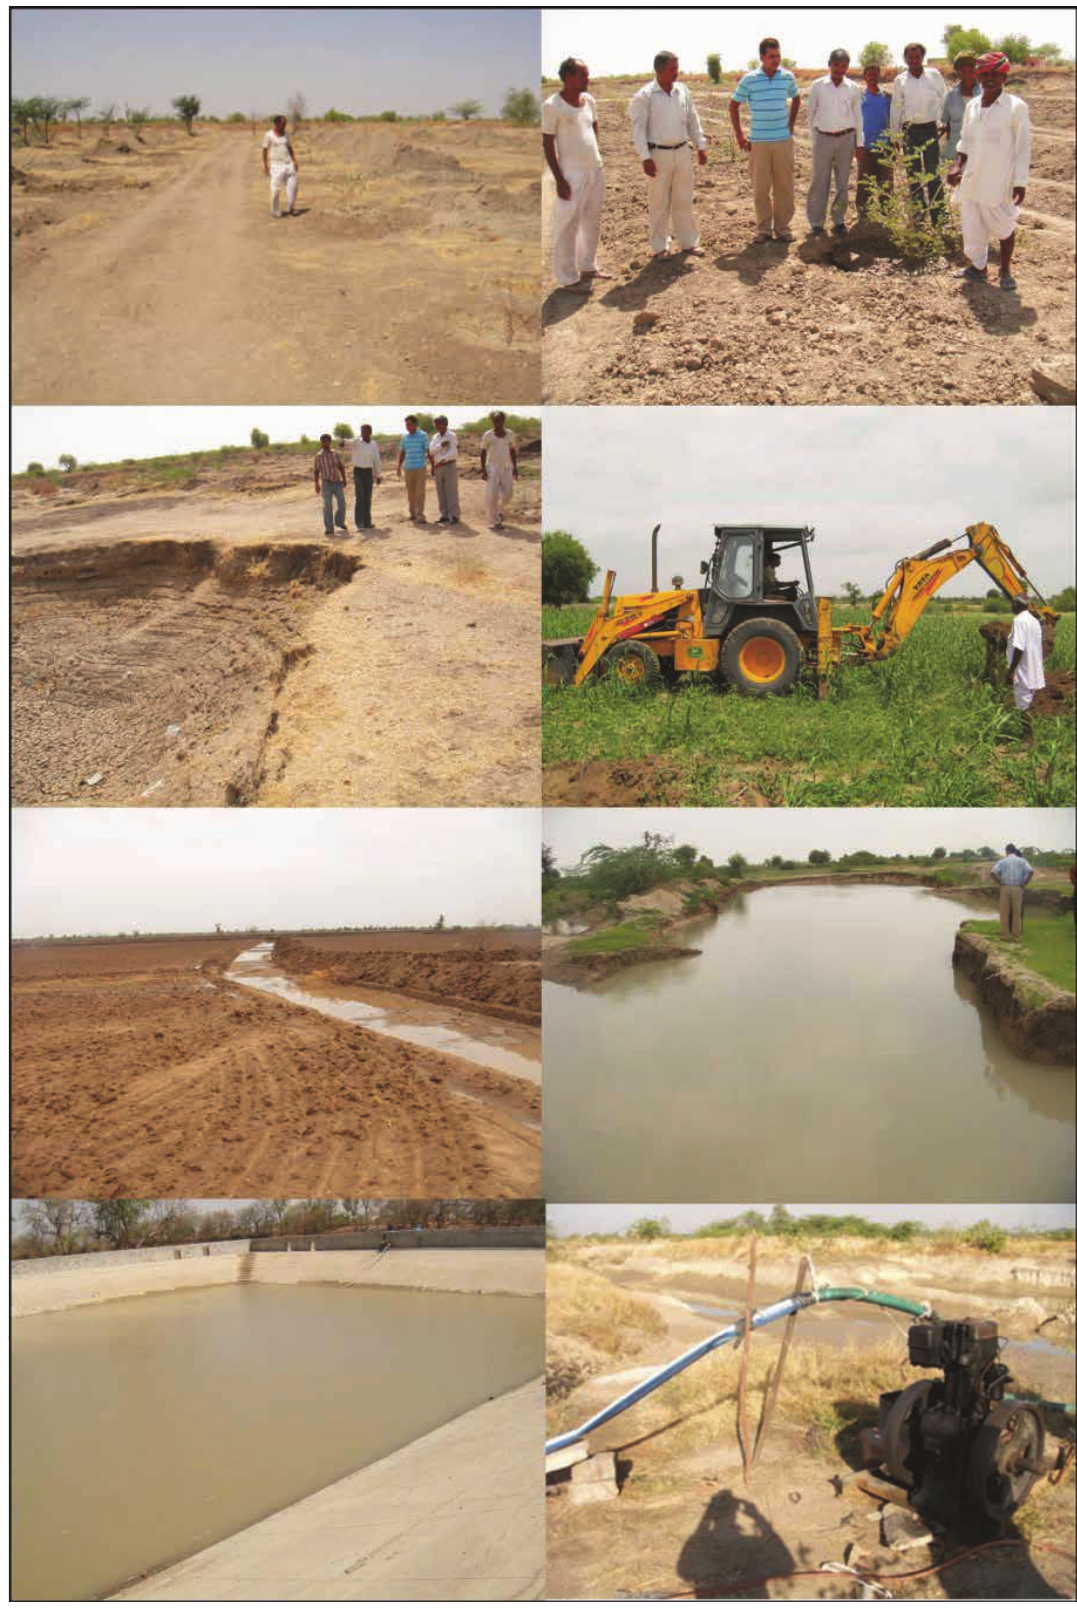
Figure 4: Different steps in creation of a viable